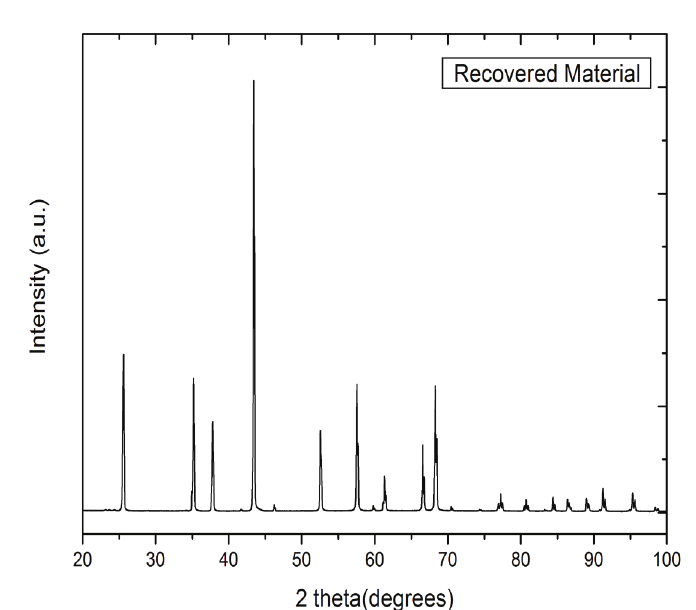
Figure 8. XRD pattern of the recovered